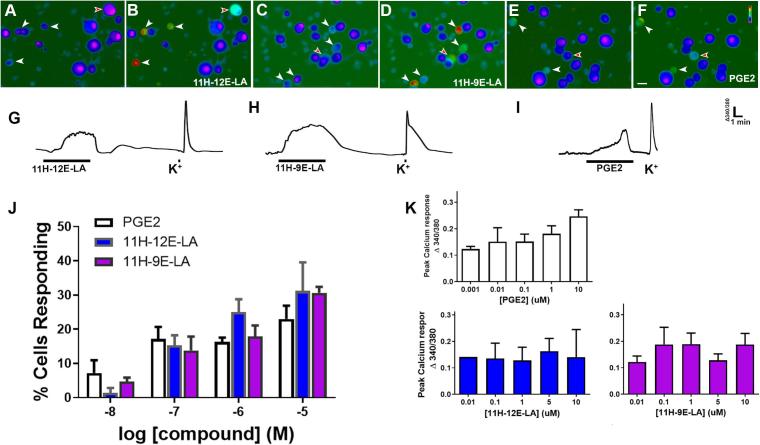
11-hydroxy-epoxide and 11-keto-epoxide derivatives of LA elicit concentration-dependent responsiveness in TNs. (A-F) Representative micrographs of dissociated mouse TNs are shown before (A, C, E) and during (B, D, F) application of 5 μM 11H-12,13E-LA, 11H-9,10E-LA, and PGE2, respectively. Arrowheads indicate Fura-2–loaded cells exhibiting Ca2+ signals in response to compound. Responses in cells depicted by red arrowhead are shown in (G-I). Representative traces showing traces of Ca2+ signals in response to 11H-12,13E-LA (G) 11H-9,10E-LA (H) or PGE2 (I) followed by 50 mM K+. (J) Concentration-response curves illustrate the increase in the number of cells responding to 11H-12,13E-LA, 11H-9,10E-LA and PGE2. (K) Average peak magnitude of Ca2+ signal is shown for increasing concentrations each compound. Data represent mean ± SEM for 5–8 mice. Scale bar = 20 μm.